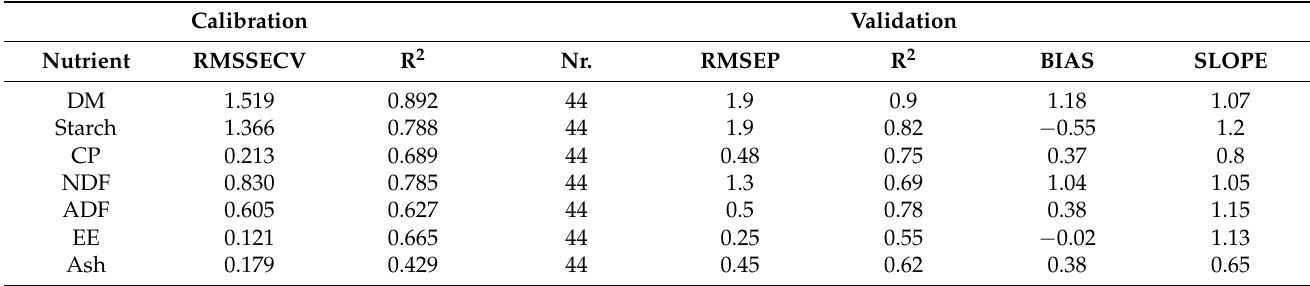
Table 2. NIRS calibration and validations of the technique utilized for silage